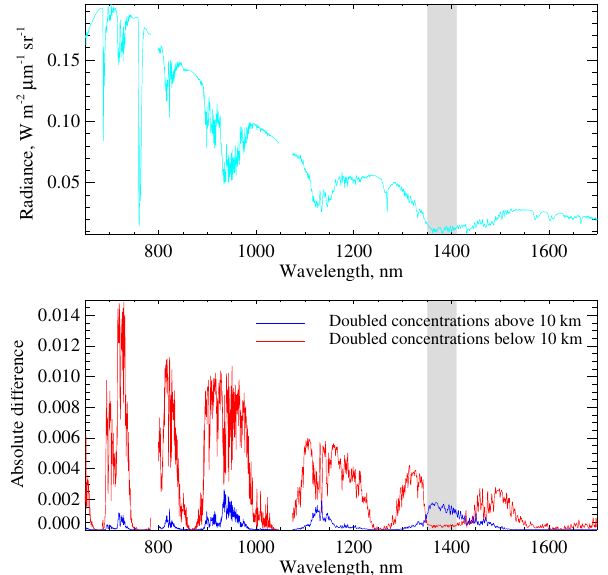
Fig. 1. Upper panel: simulated limb radiance in spectral channels 4, 5, and 6 of SCIAMACHY at a tangent height of 12km. The spectral channels are separated by gaps. Lower panel: absolute differences in the simulated radiance due to doubling of water vapor amounts above (blue curve) and below (red curve) 10km. Positive differ- ences mean that changes in the water vapor abundance lead to a decrease in the limb radiance. Grey shaded areas mark the spectral range that is found to be optimal for the UTLS water vapor